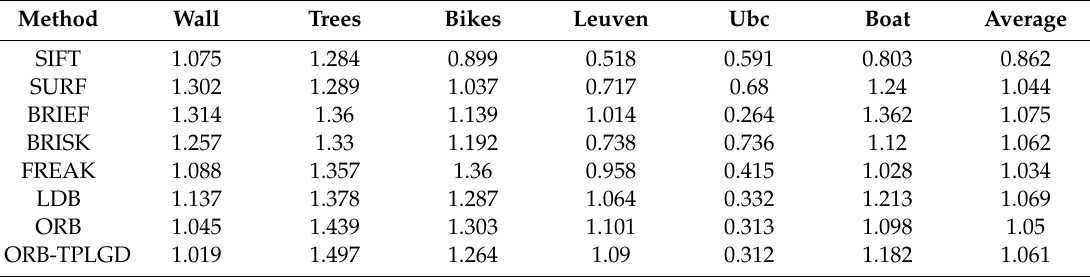
Figure 10. Average matching RMSE based on Oxford dataset. Table 6. Average matching RMSE based on Oxford dataset (pixel).